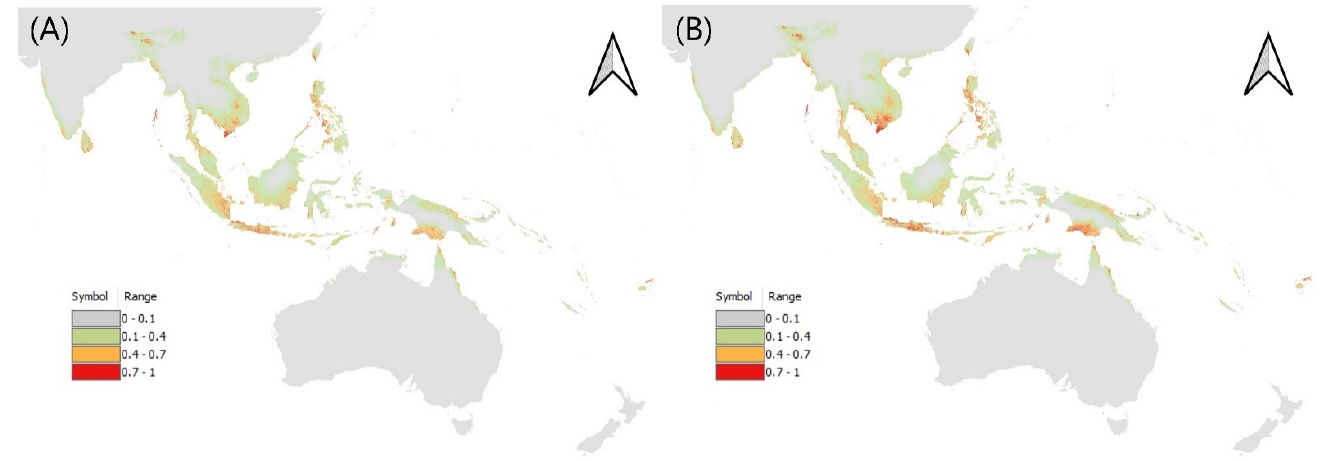
Figure 4. Potential distribution of L. oratoria ( A ) under current climate, and ( B ) for 2081–2100.